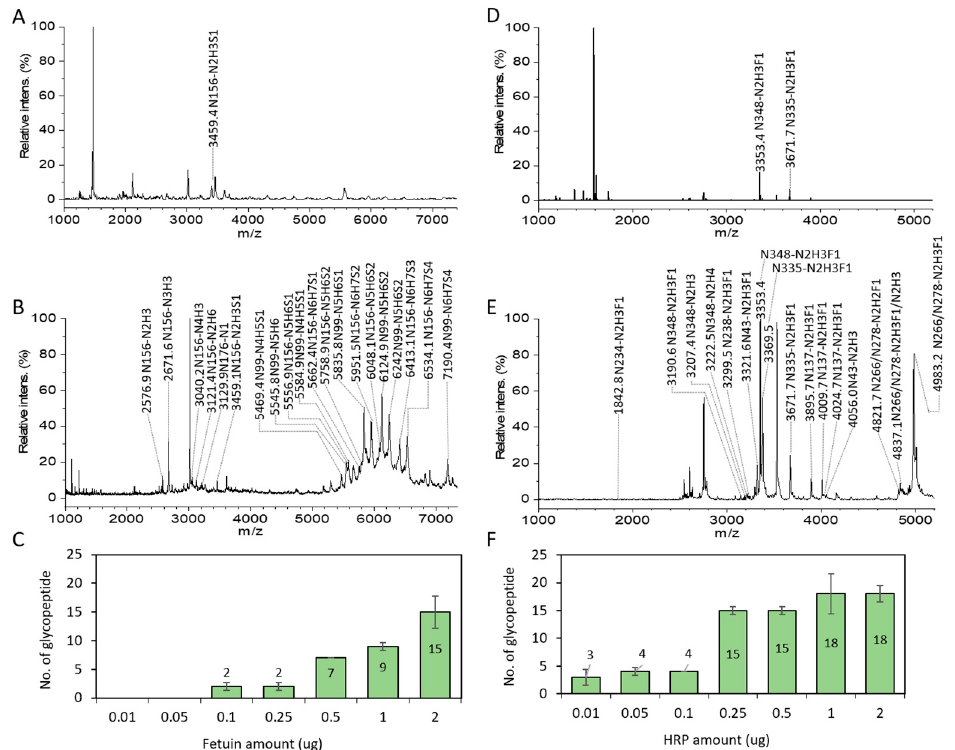
Figure 3. Detection of intact glycopeptides from 2 µ g fetuin and HRP by MALDI-TOF mass spectrometry analysis. MALDI-TOF spectra of standard fetuin and HRP before enrichment ( A , D ) and after enrichment ( B , E ) using ZIC-cHILIC@MNPs, respectively. Number of detected glycopeptide against different amounts of standard fetuin ( C ) and HRP ( F ) using